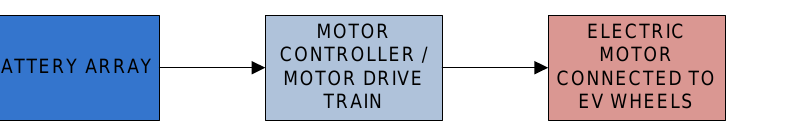
Figure 2. Major components of an electric vehicle.